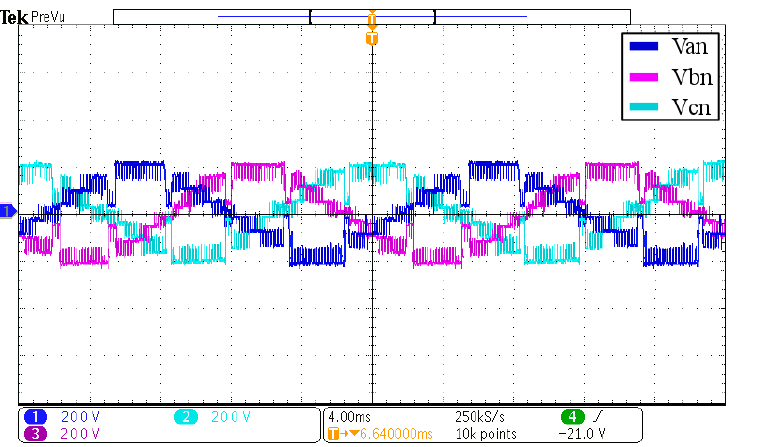
Figure 21. Experimental waveform of AHMMC output phase voltages at M f = 0.9 tracing channels 1, 2, 3 (200